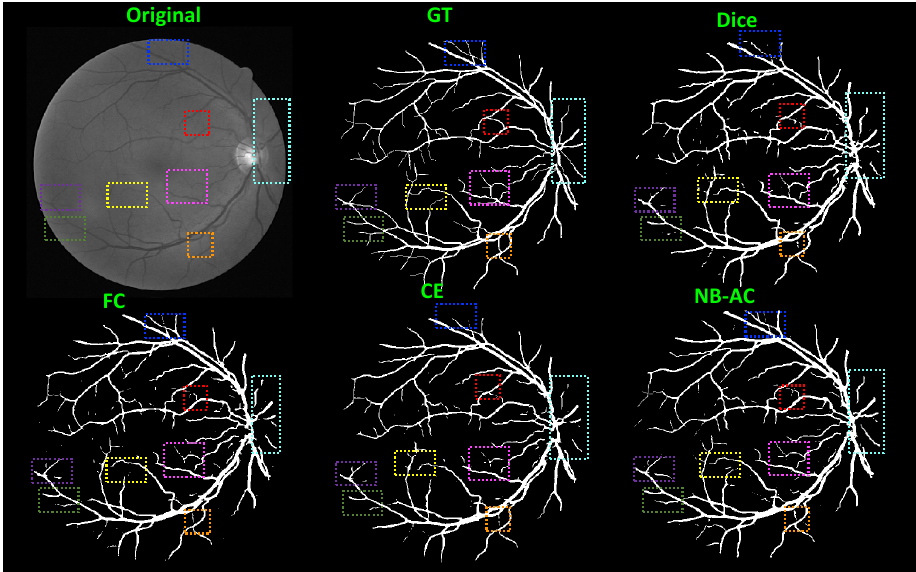
Figure 8. Comparison between our results against other loss functions on the Unet framework. The image is from the DRIVE dataset.